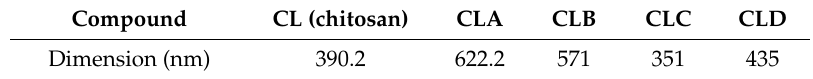
Figure 1. Obtaining scheme of CLA nanoparticles. Table 1. Size of chitosan-sulfonamide